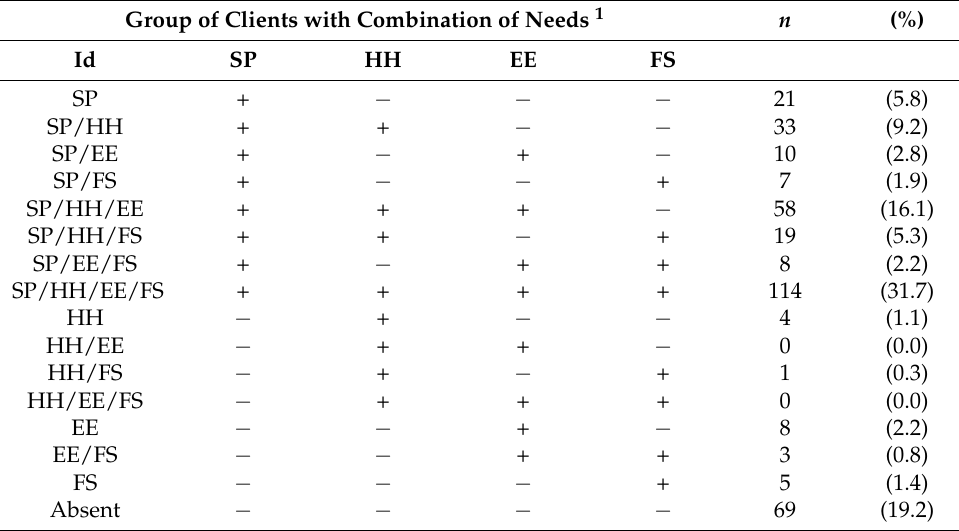
Table 1. The combination of four needs domains among the adult day care clients. Group of Clients with Combination of Needs 1